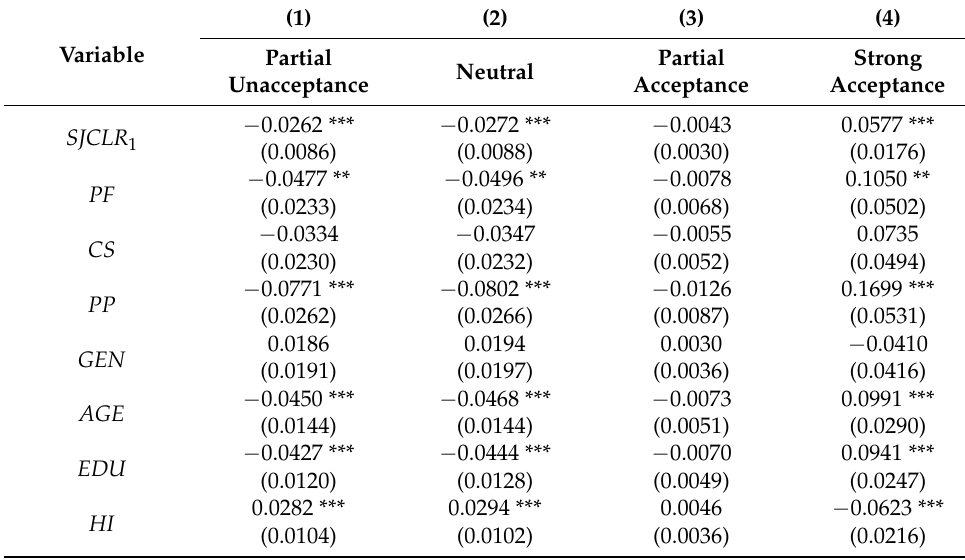
Table 5. Marginal effects of explanatory variables in the ordered probit